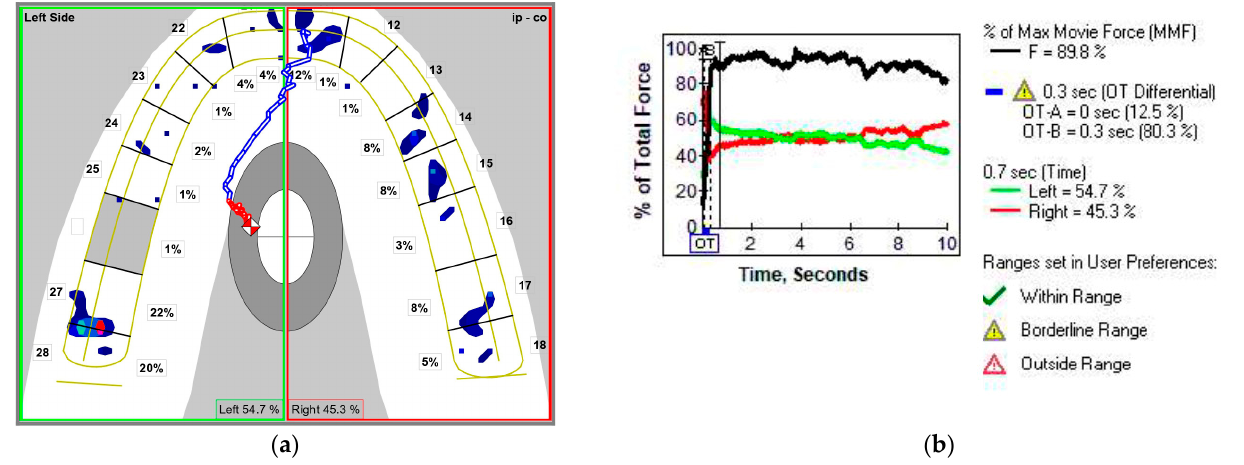
Figure 4. MA frame of the T-Scan registration of MC subject in NHP: ( a ) two-dimensional (2D) view with the distribution of the occlusal force between the left and the right side of the arch; ( b ) graph of the % of the total force in time, with %MMF, OT, OTB, and MAT (0.7 s).